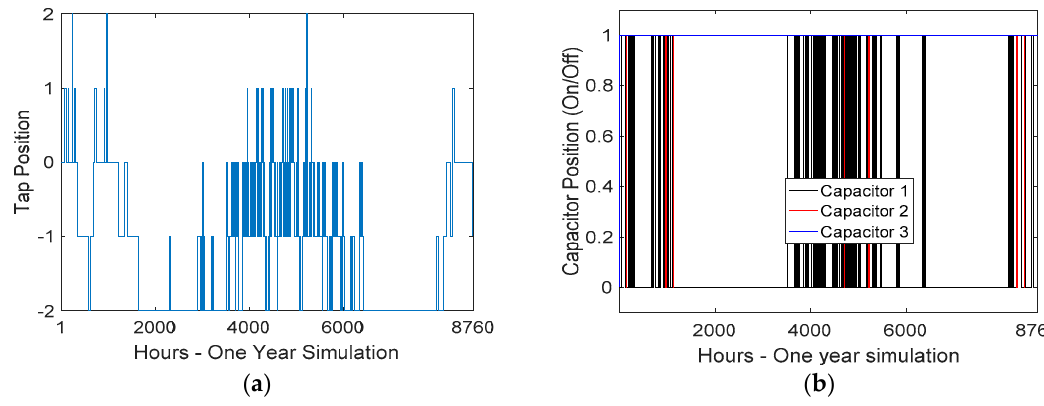
Figure 10. No control for PV inverters: ( a ) Regulator tap operation; ( b ) Capacitor bank switching.